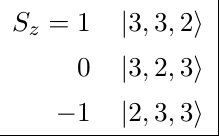
Table 4 . The states of L (3 ; 3 ;